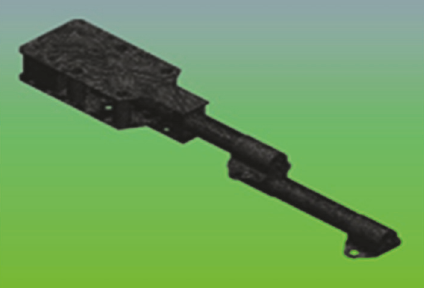
Figure 12: Finite element analysis model of steamer-filling